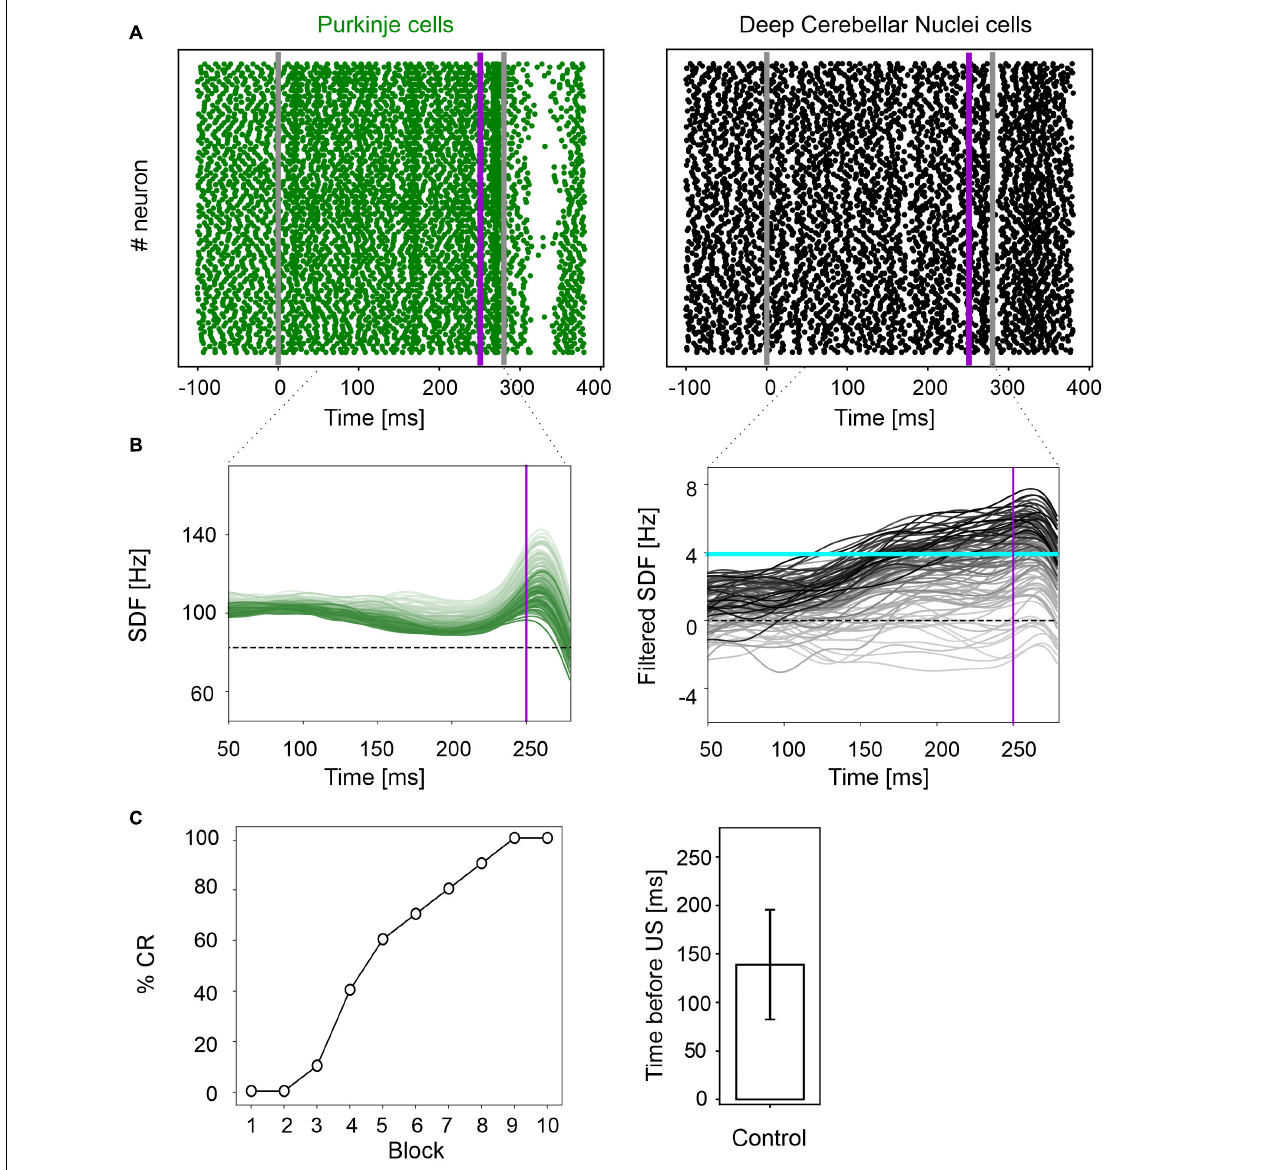
FIGURE 2 | EBCC simulations in the control condition. (A) Exemplificative raster plots showing spiking activity of each cell (y axis) within PC (green) and DCN (black) populations in the first trial. Gray vertical lines represent the CS onset and end, purple line marks the US onset (which co-terminates with CS). (B) SDF in PC population and DCN motor output (averaging across cell SDFs) for each trial (0 ms is aligned with the CS onset). Increasing darkness of the lines corresponds to subsequent trials (the lightest is the first trial, the darkest is the last trial). Dashed horizontal line indicates baseline activity, solid horizontal cyan line (right panels) represents the CR threshold. Purple vertical line corresponds to US onset time. (C) Behavioral EBCC outcome: %CR along trial blocks (left panel), and CR timing with respect to US onset (right panel). Error bar indicates the standard